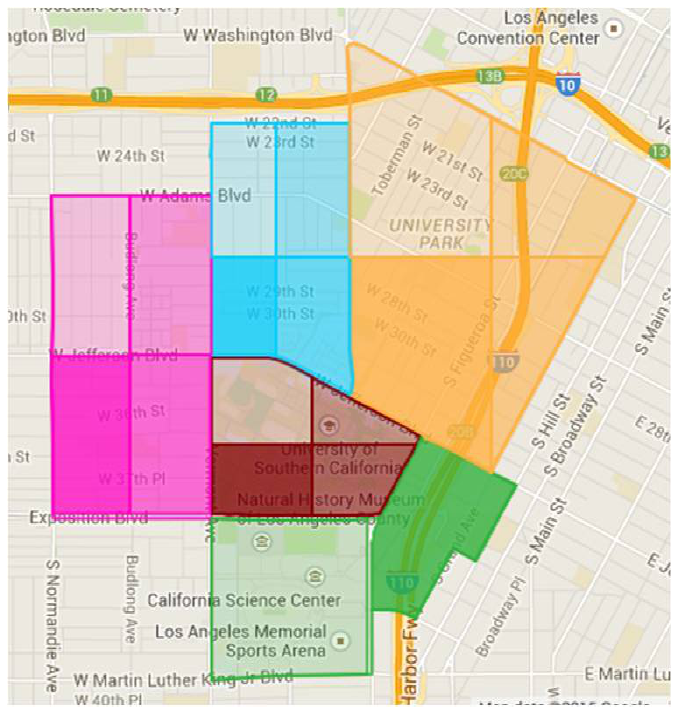
Figure 9. Patrol area.